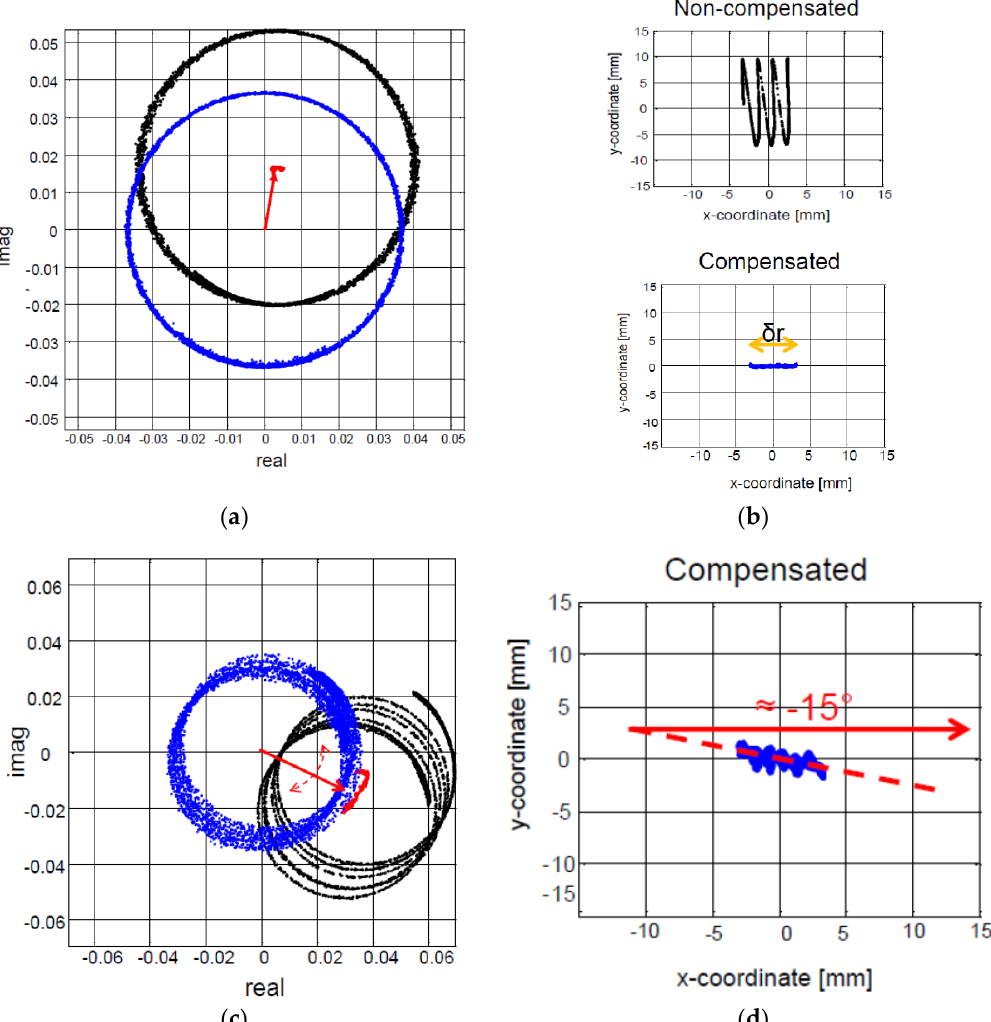
Figure 11. Estimation of 2D vibrations by closely spaced Radars in laboratories. ( a ) CSP diagram for the case of displacement along x axis. ( b ) Motion retrieved before ( top ) and after ( bottom ) the proposed compensation. ( c ) CSP diagram for displacement of 15 ◦ in the x , y plane. The interference was time-varying and called for a time-varying compensation. ( d ) Estimated motion (blue) and true track (red): The residual error is less than a hundred of